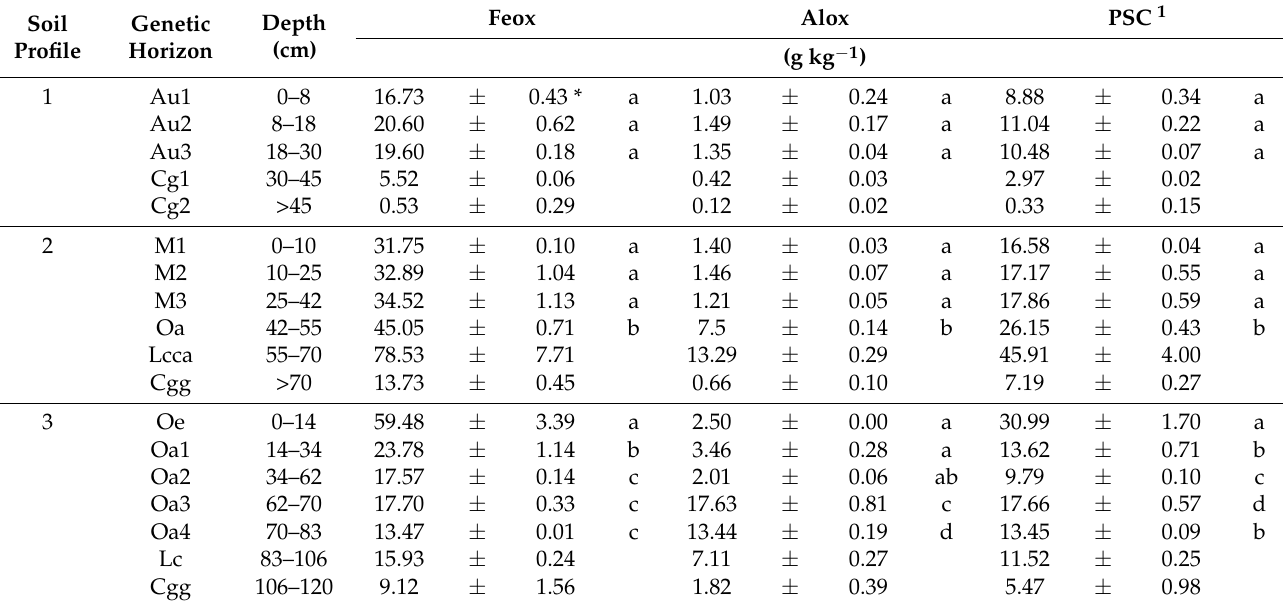
Table 3. Amorphous Fe and Al content and